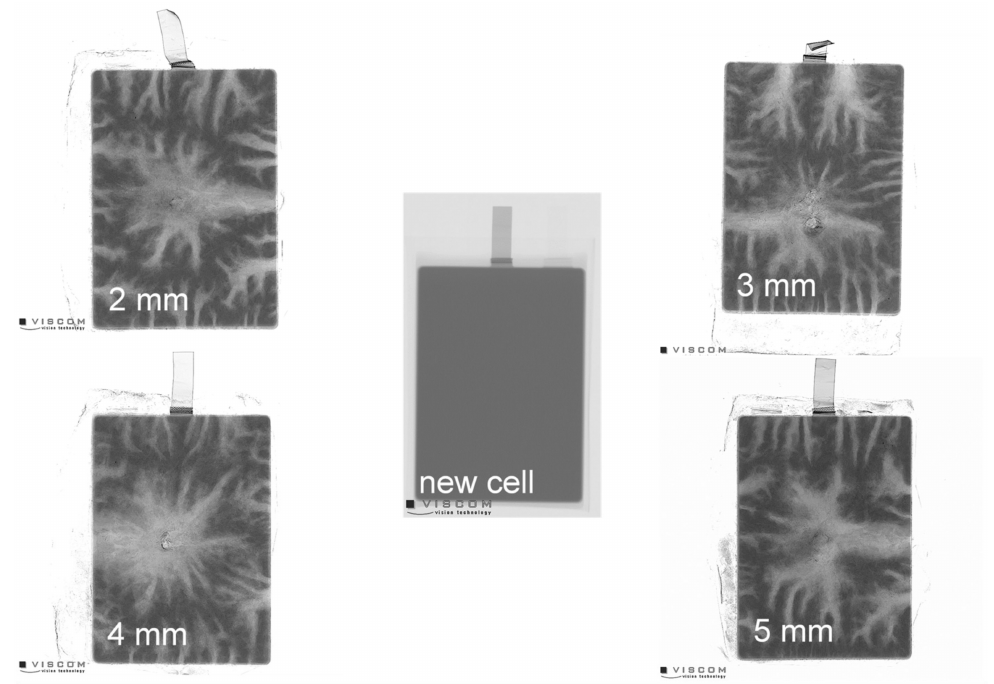
Figure 4. X-ray images of 5.3 Ah cells before and after the nail penetration test with different nail geometries from 2 to 5